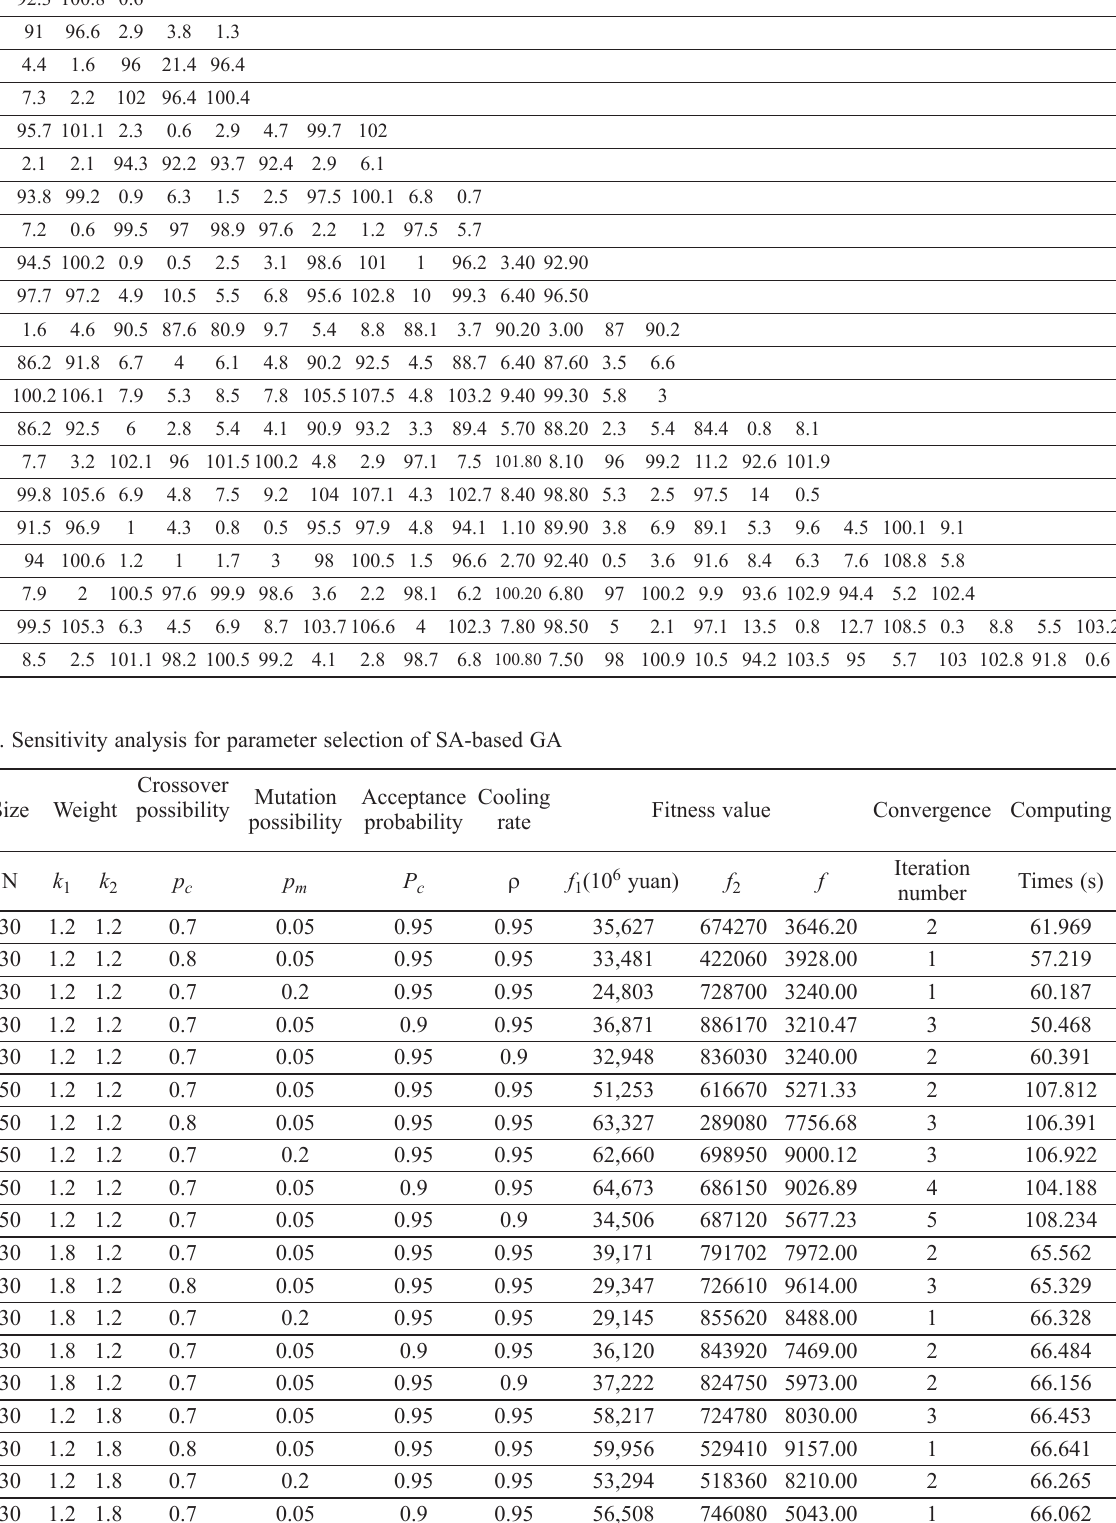
Table 5. The distance d ik , jl between different possible locations of the facilities (b) No.